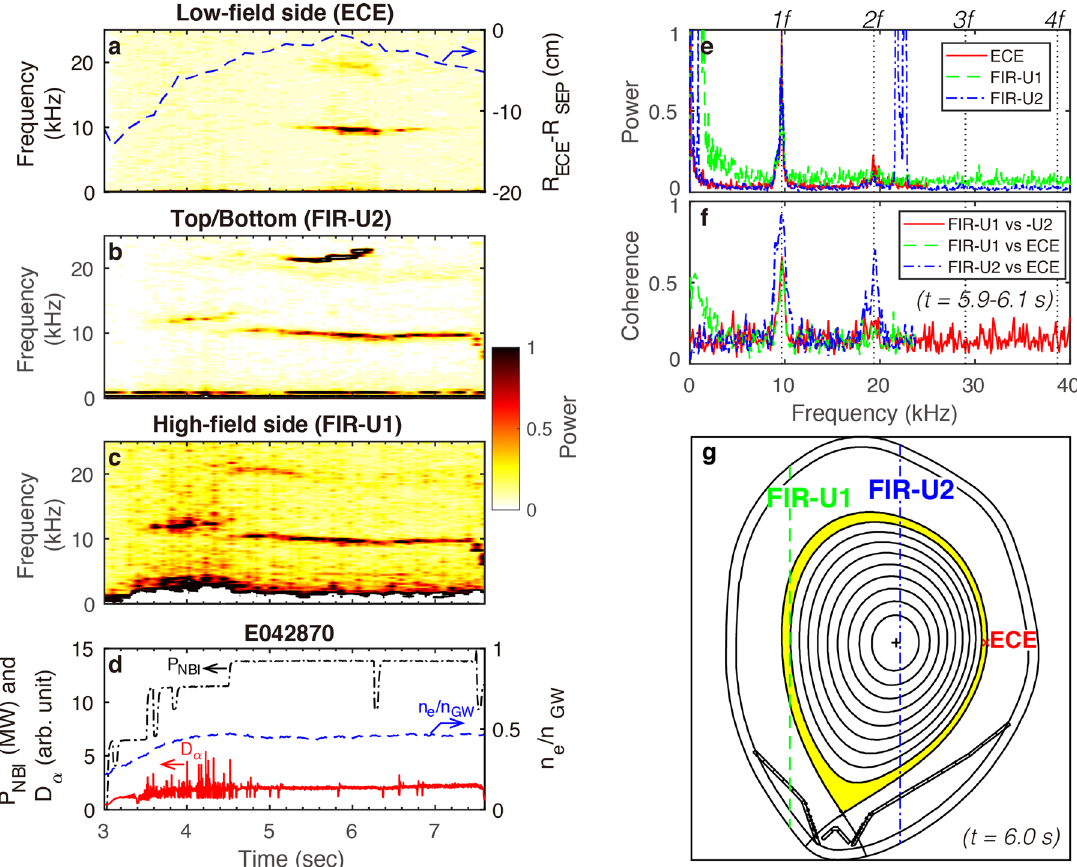
Fig. 1 Quiescent high-con fi nement mode (QH-mode) shot (discharge E042870). Fourier analysis of signals (normalized at t = 6.0 s) ( a ) from the electron – cyclotron emission (ECE) at the low- fi eld-side (LFS), together with its measurement position relative to the separatrix (R-R SEP ), and from the far- infrared (FIR) laser interferometers for ( b ) the Top/Bottom (FIR-U2) and ( c ) the high- fi eld-side (HFS) (FIR-U1) chords. d The total neutral-beam-injection power (black dash-dot line), D α emission from the divertor (solid red line), and line-averaged electron density normalized by the Greenwald density (blue dashed line). The frequency dependences of ( e ) the normalized power spectra for the ECE and FIR-U1 and -U2 and ( f ) their respective coherences evaluated at t = 5.9 – 6.1 s. g Diagnostic locations and magnetohydrodynamic equilibrium reconstruction (from the FBEQU-code) at t = 6.0 s, in which hatched area denotes the peripheral plasma region of the normalized poloidal- fl ux value of 0.9 ≤ ψ N ≤